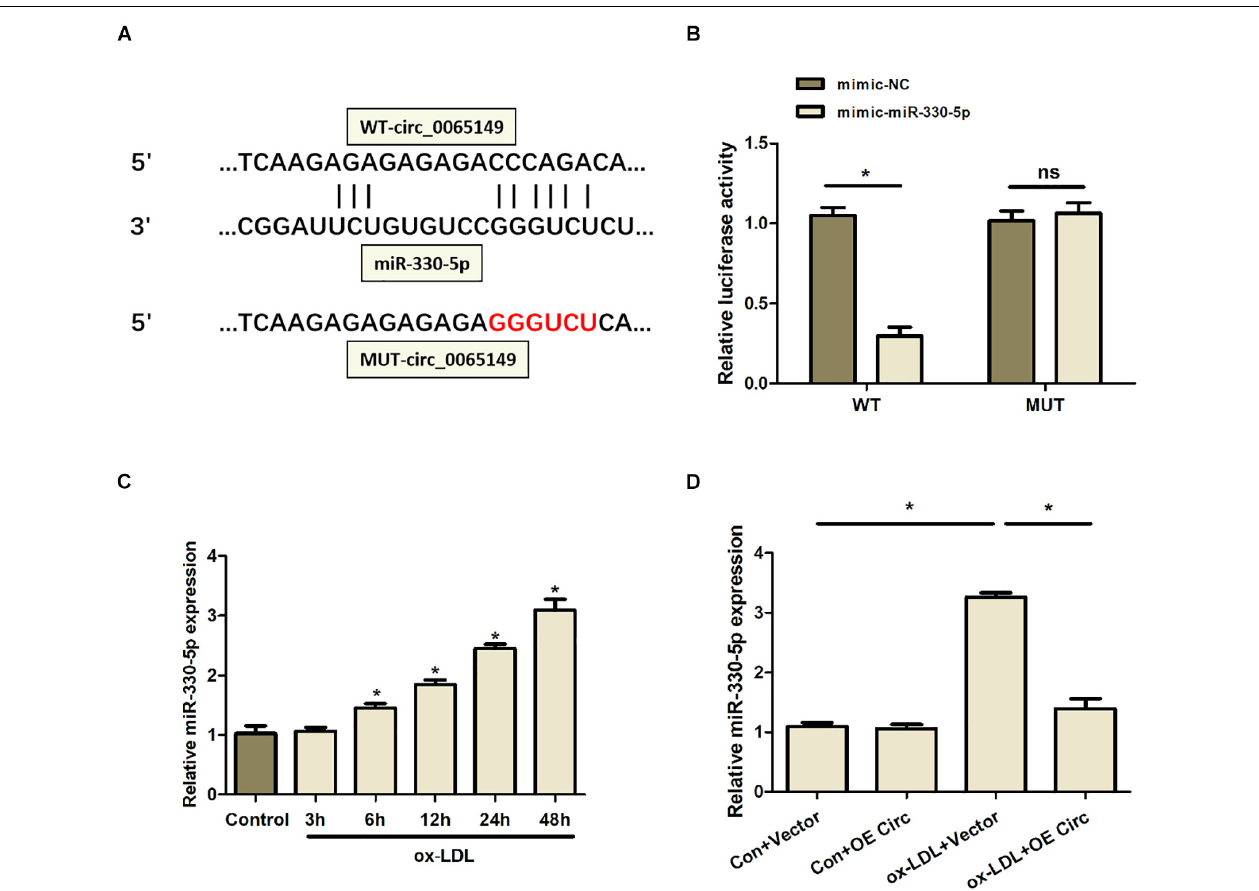
FIGURE 4 | Overexpression of circ_0065149 decreased the expression of miR-330-5p in ox-LDL-induced HUVECs. (A) Predicted binding sites between circ_0065149 and miR-330-5p. (B) Luciferase activity of circ_0065149 in ox-LDL-induced HUVECs transfected with miRNA mimics. * P < 0.05, mimic-miR330-5p vs. the mimic-NC group; ox-LDL + OE Circ vs. the ox-LDL Vector group. (C) Expression of miR-330-5p in ox-LDL-induced HUVECs over time. * P < 0.05 vs. the Control group. (D) Expression of miR-330-5p in HUVECs treated with different conditions. * P < 0.05, Vector vs. the Control group; ox-LDL + OE Circ vs. the ox-LDL Vector group. Data are shown as means ± SD